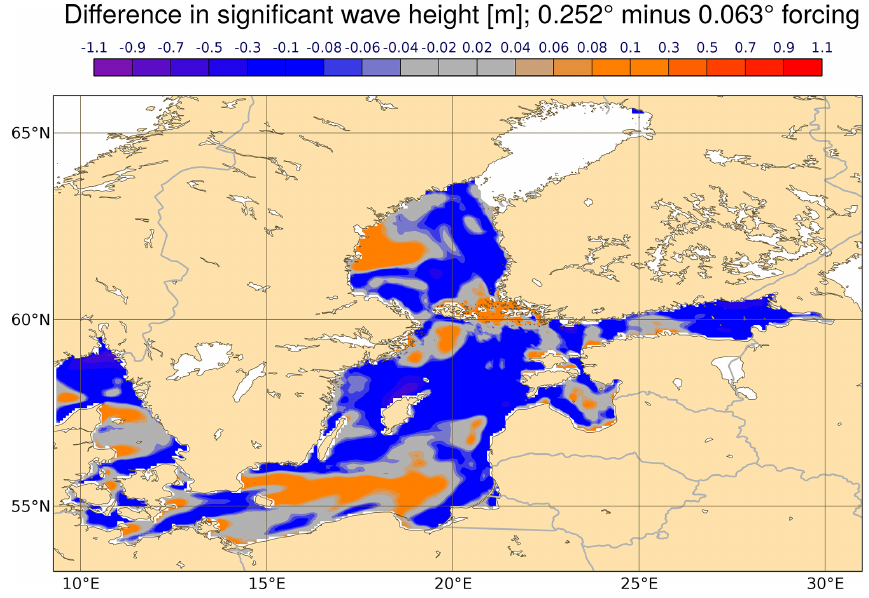
Figure 10. Difference in the significant wave height (m) in WAVEWATCH III ® between simulation driven by WRF with 0.252 ◦ and by 0.063 ◦ in 15min temporal resolution at 22 February 2002 21:00UTC. The northern part of the Gulf of Bothnia is covered by sea